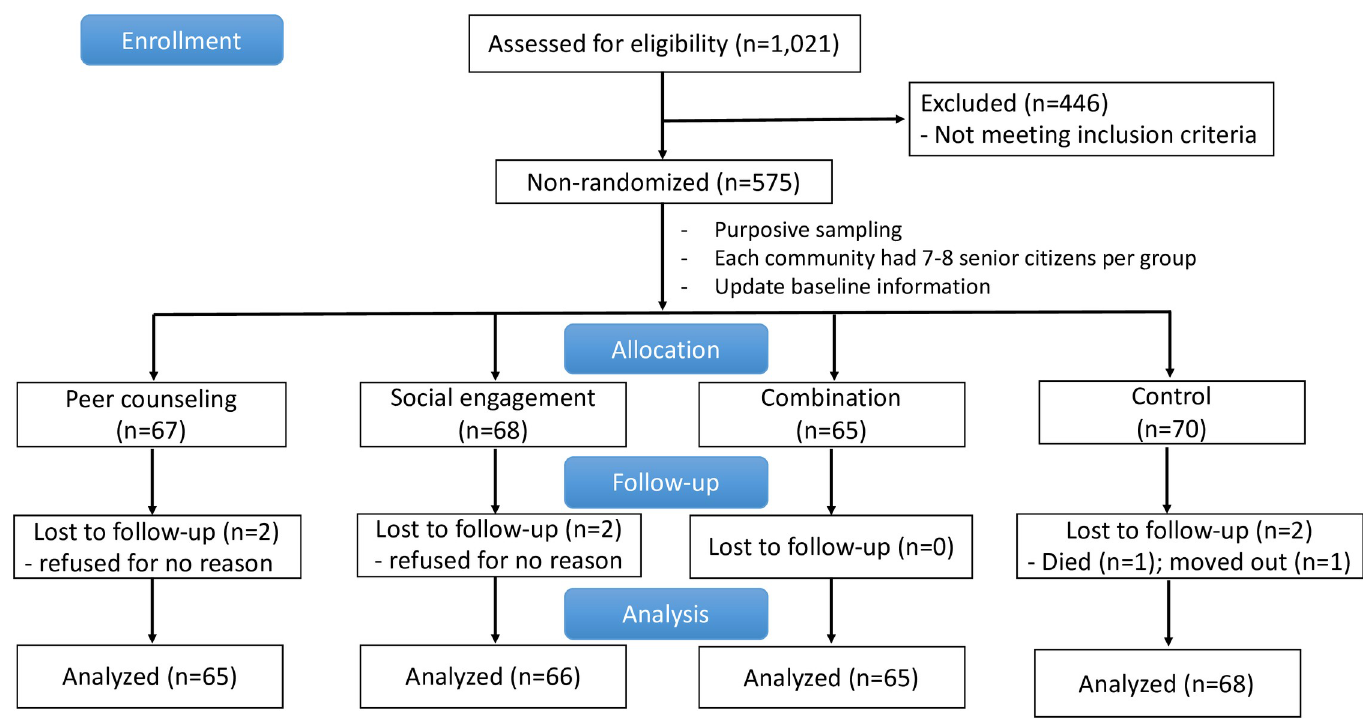
Fig 1. Flow chart of Phase 3 ENGAGE intervention